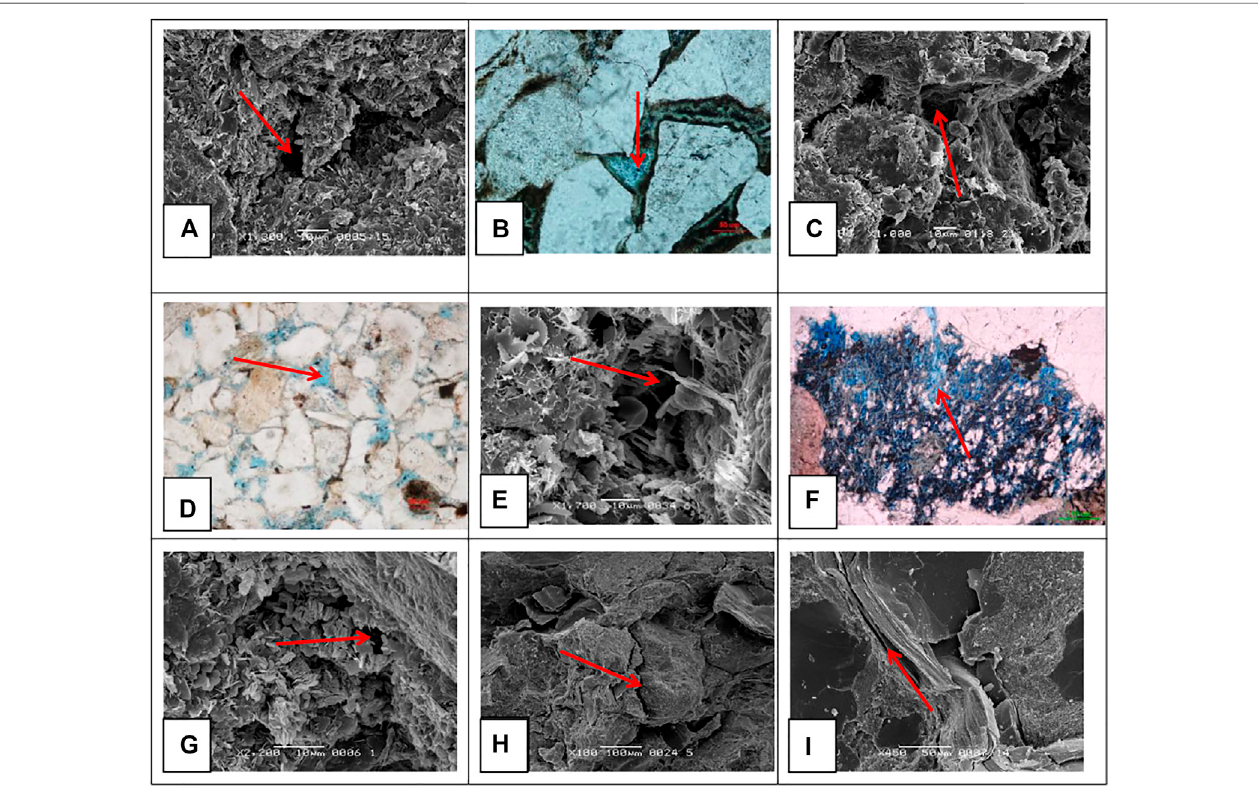
Frontiers in Earth Science |